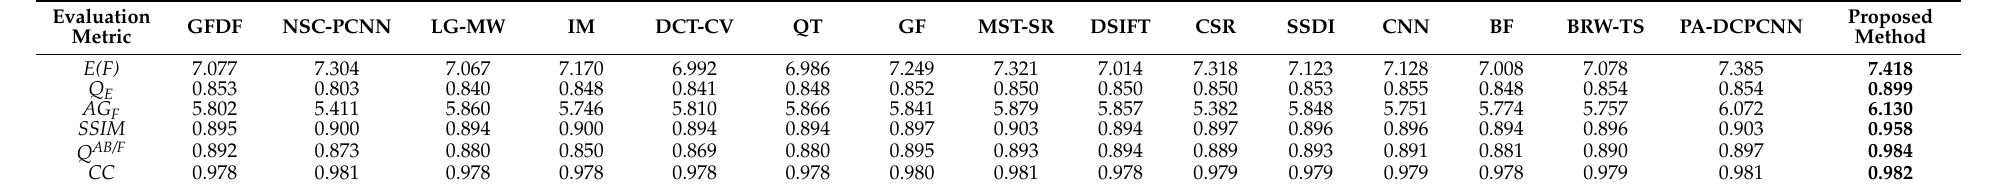
Table 3. The outcomes for the clock image and comparisons with existing techniques in the literature ([21]). Evaluation Metric